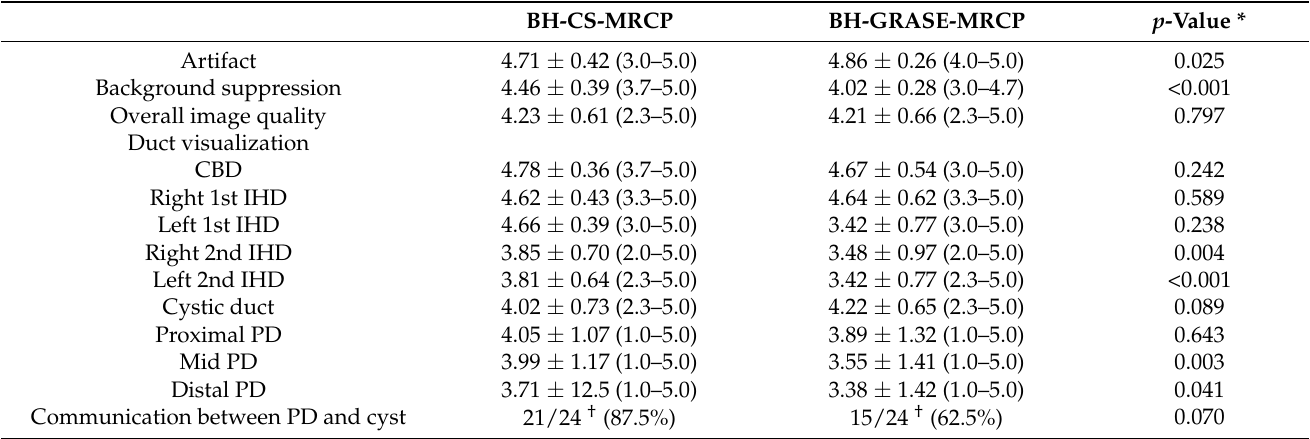
Table 2. Comparison of image quality between BH-CS-MRCP and BH-GRASE-MRCP.